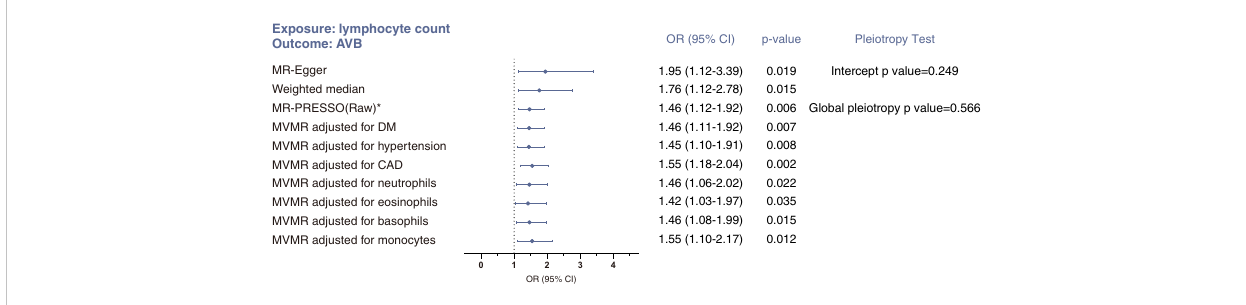
FIGURE 2 Sensitivity analyses of the causal association between lymphocyte count and risk of atrioventricular block using MR-Egger, weighted median, MR- PRESSO and multivariable MR (MVMR) analyses. *No outlier was detected. Statistical signi fi cance was de fi ned as p<0.05.